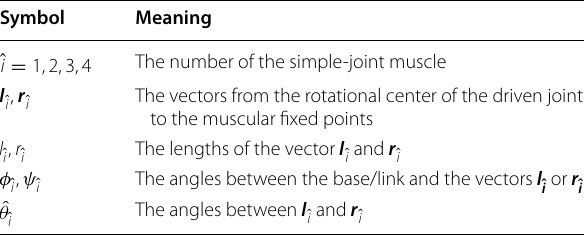
of simple-joint muscular